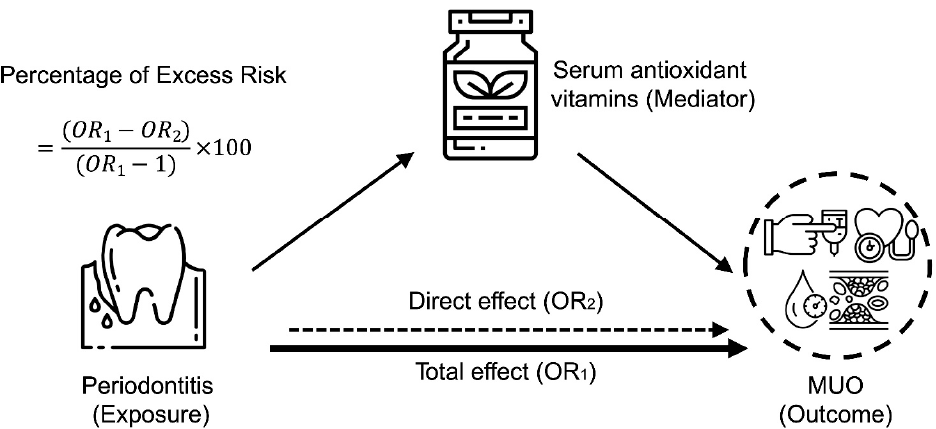
Figure 2. Mediating effect of oxidative stress on the relationship between periodontitis and metabolically unhealthy overweight and obese phenotype among the NHANES III population. Schematic diagram illustrating the statistical analysis, using periodontitis as an exposure, serum antioxidant vitamins as mediators, and MUO as an outcome.